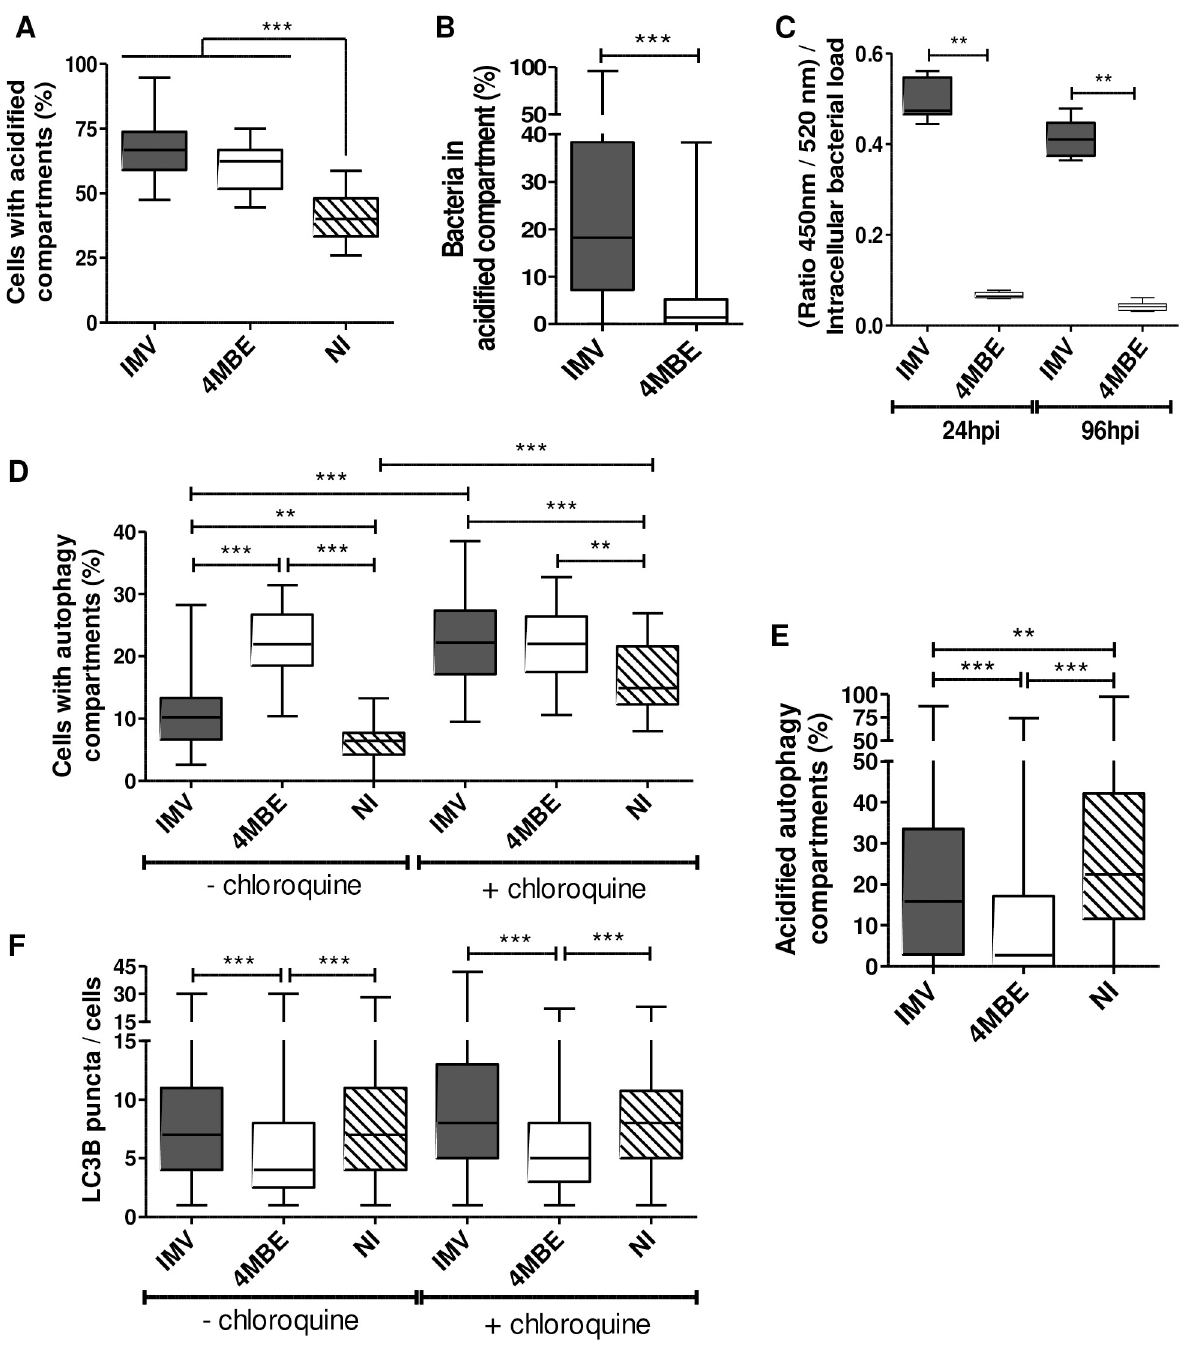
Fig 6. Improved intra-macrophagic survival of the 4MBE variant is due to phagolysosome avoidance and inhibition of autolysosome formation. Macrophages were infected by the IMV (black) or the 4MBE variant (white) at a MOI of 10:1 or not infected (NI; hatched) as a control. (A-B and D-F) At 24 hpi, cells were stained with LysoTracker Red DND-99, anti-Mtb coupled FITC, and anti-LC3B coupled Dy-Light 650 antibodies. Cells with acidified (A) or autophagy compartments (D) were determined across at least 10 confocal images, containing between 30 and 80 cells per image, per replicate. Proportion of bacteria in acidified compartments (B), proportion of acidified autophagy compartments (E), and LC3B puncta per cells (F) were determined across at least 40 cells per replicate. (D and F) Three hours before staining, cells were incubated with chloroquine, then macrophages were stained and analyzed as previously described. (A-B and D-F) Values for each condition are the median values [interquartile range, IQR] of at least three independent experiments. Statistical significance was determined using Kruskal-Wallis analysis, using Dunn’s Multiple Comparison Test or Mann Whitney test, where appropriate. (C) Infected macrophages were loaded with CCF4-AM at 24 and 96 hpi to analyze 450nm/520nm ratio normalized to bacterial load. Values for each condition are the mean ± standard deviation (SD) of at least three independent experiments. Means were compared using Mann Whitney test. � p < 0.05, �� p < 0.01, ��� p < 0.001. https://doi.org/10.1371/journal.ppat.1009643.g006 PLOS Pathogens| https://doi.org/10.1371/journal.ppat.1009643 June 24,